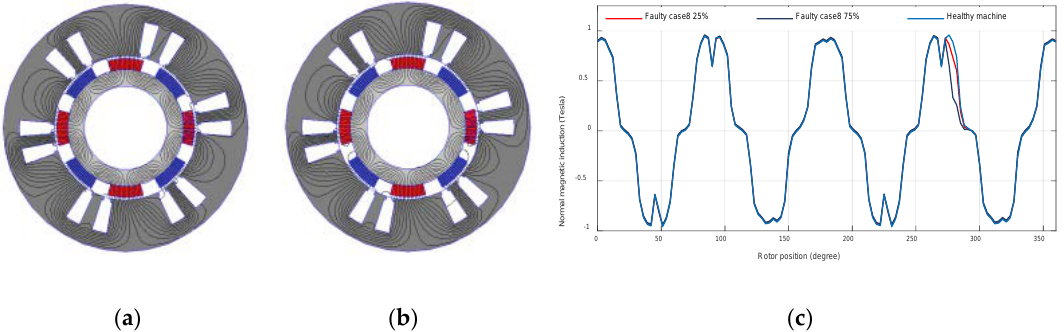
Figure 16. Faulty case 8: ( a ) Magnetic field under 25%; ( b ) magnetic field under 75%; ( c ) airgap magnetic flux density.